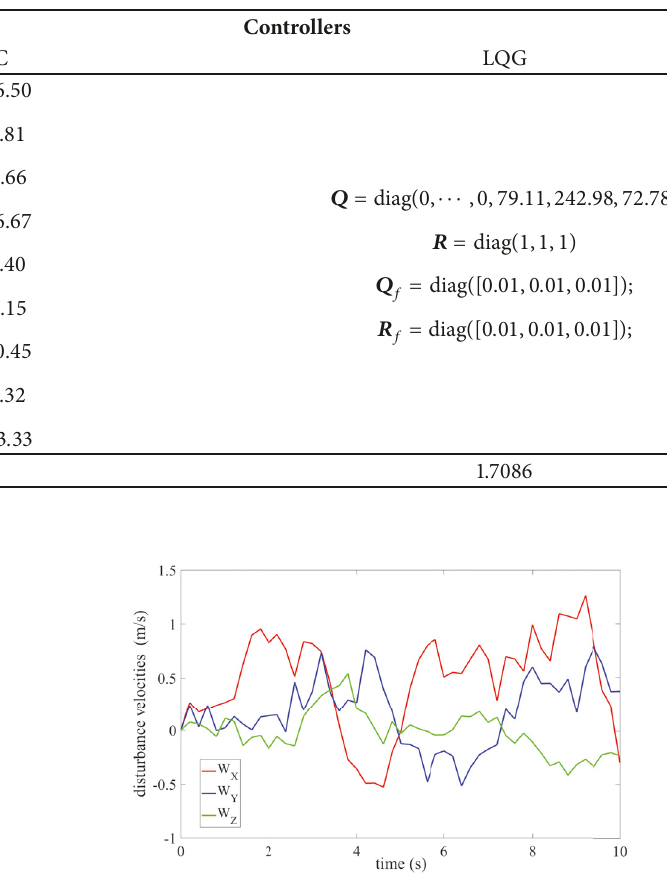
Table 3: Parameters of LADRC and LQG.